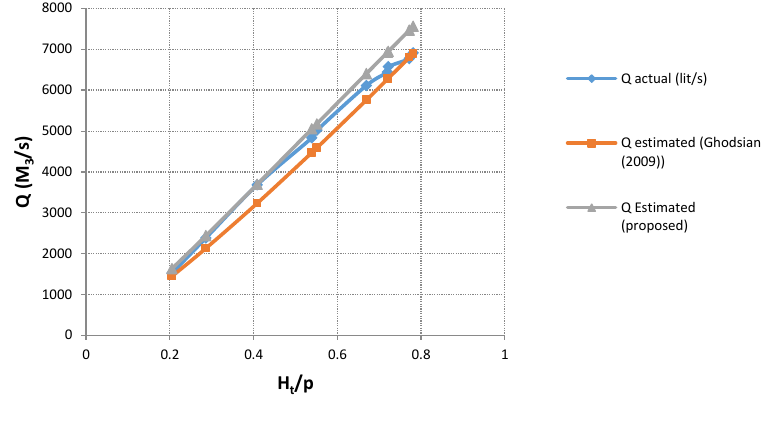
Figure 6. Comparison between the flow of Bartletts Ferry dame in the US in various 𝑯 𝒕 calculated flow through the equation proposed by the author and Godsian